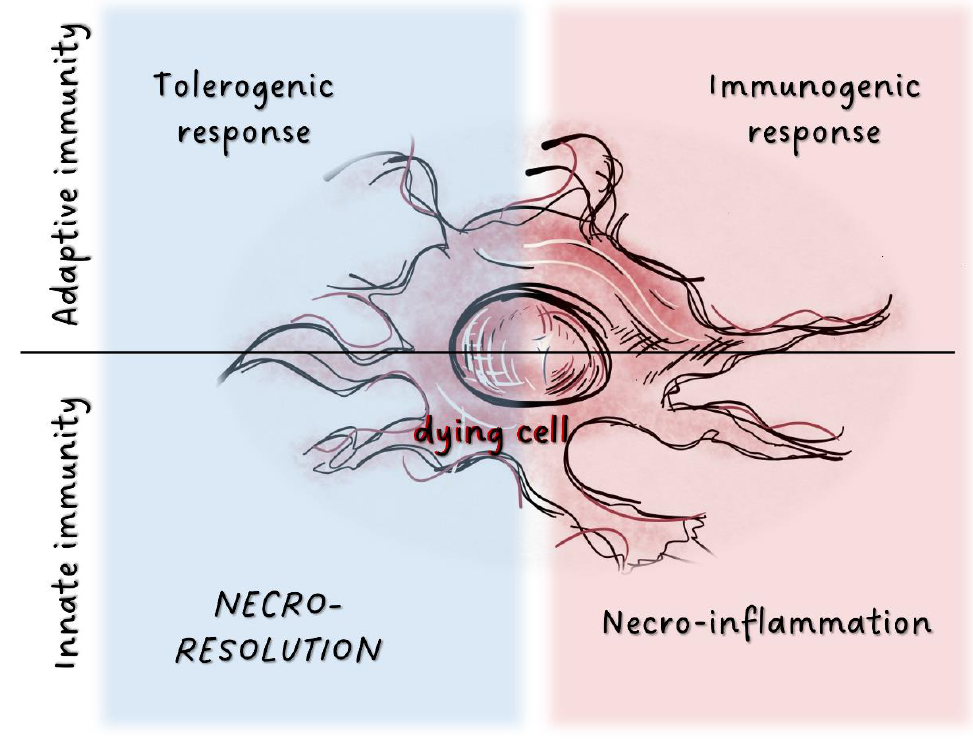
Figure 1. Potential immunological outcome of cell death processes.In adaptive immunity, factors released from dying cells are detected by various cell populations localized in tissues. This triggers either tolerogenic or immunogenic responses. Tissue damage results in the activation of the innate immune system through release of inflammatory mediators. Factors associated with dying cells can also induce immunosuppression as the inverse of inflammation, and dead cells may activate tissue